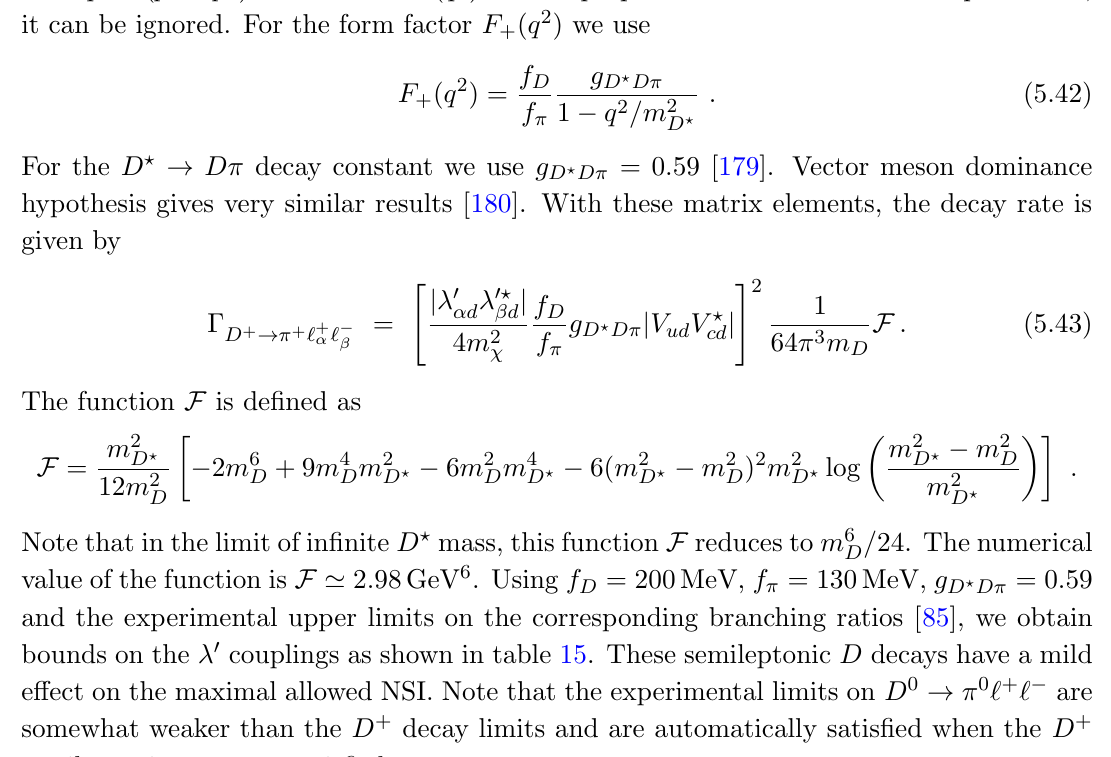
( q 2 ) term is proportional to the (cid:12)nal state lepton (cid:0)